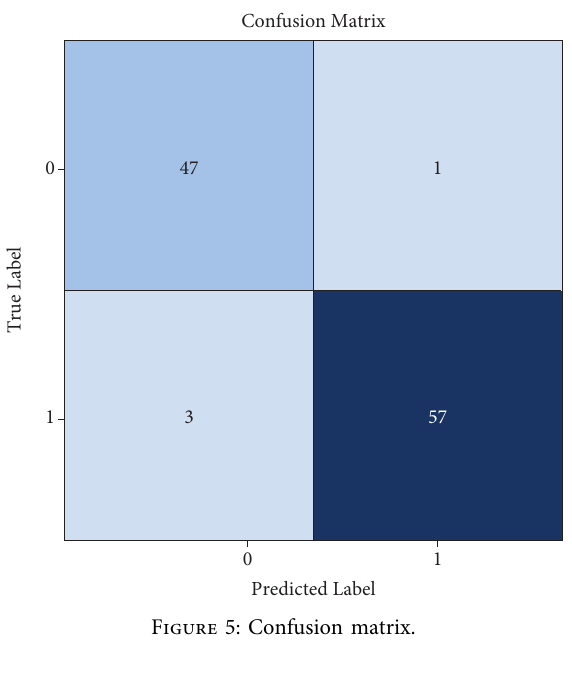
Figure 5: Confusion